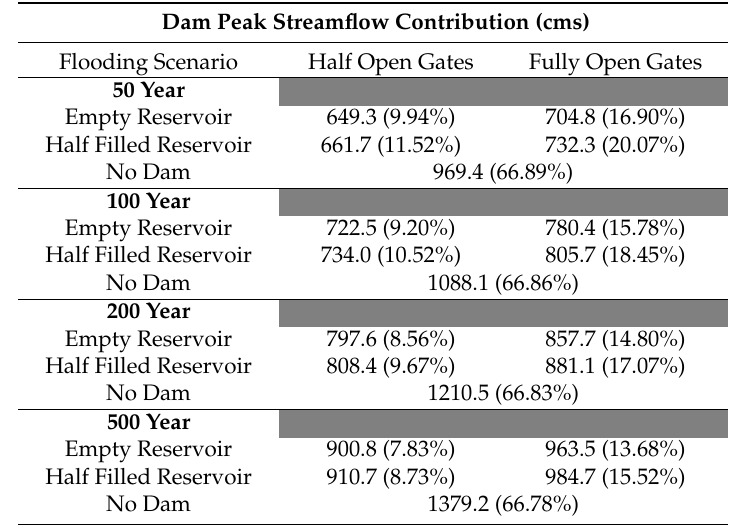
Table 1. Thomaston Dam outflow contribution to downstream basin outlet peak